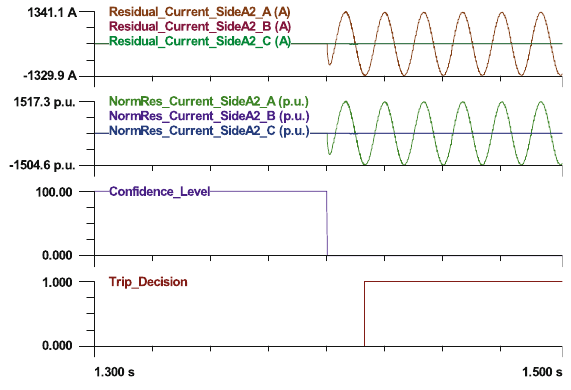
Fig. 7 EBP relay performance of event 1: internal bolted fault, grid-connected